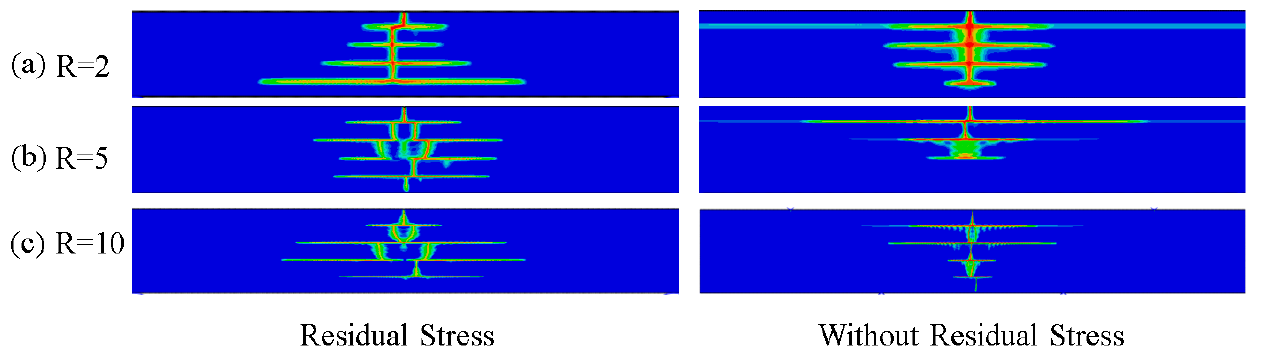
Figure 7. Numerical simulation results of the four-point bending of laminated ceramics with different layer thickness ratios.